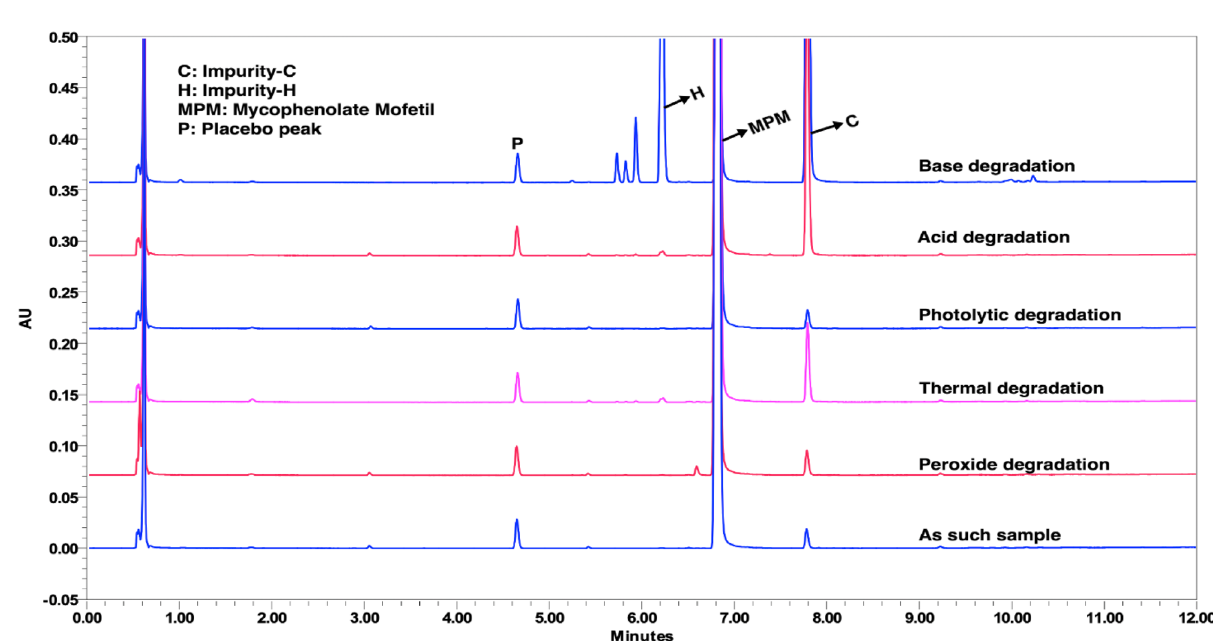
Figure 5. An overlaid chromatogram from the stress study experiments. Chromatographic conditions: MP-A: pH 4.05 KH 2 PO 4 (25 mM); MP-B: Water: ACN = 30:70 (v/v); Initial gradient composition MP-A:MP-B (87:13); Column: Acquity UPLC BEH C18 (100 mm × 2.1 mm), 1.7 µm; Flow rate: 0.4 mL min −1 ; Column temperature: 30 °C; Injection volume: 5 µL; and Wavelength detection: 215